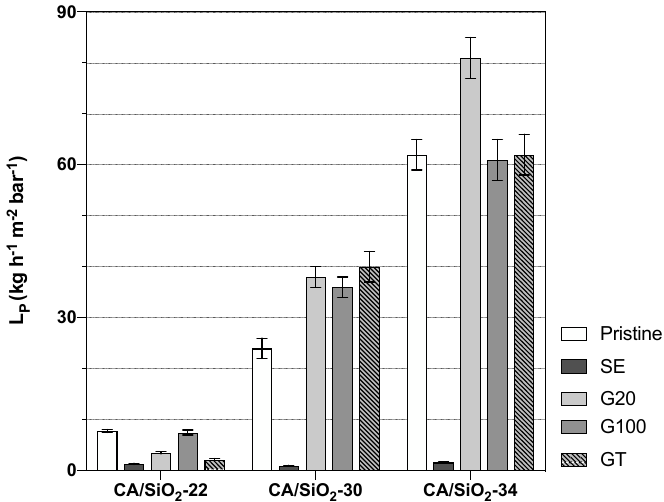
Figure 4. Membranes’ hydraulic permeabilities, L P .